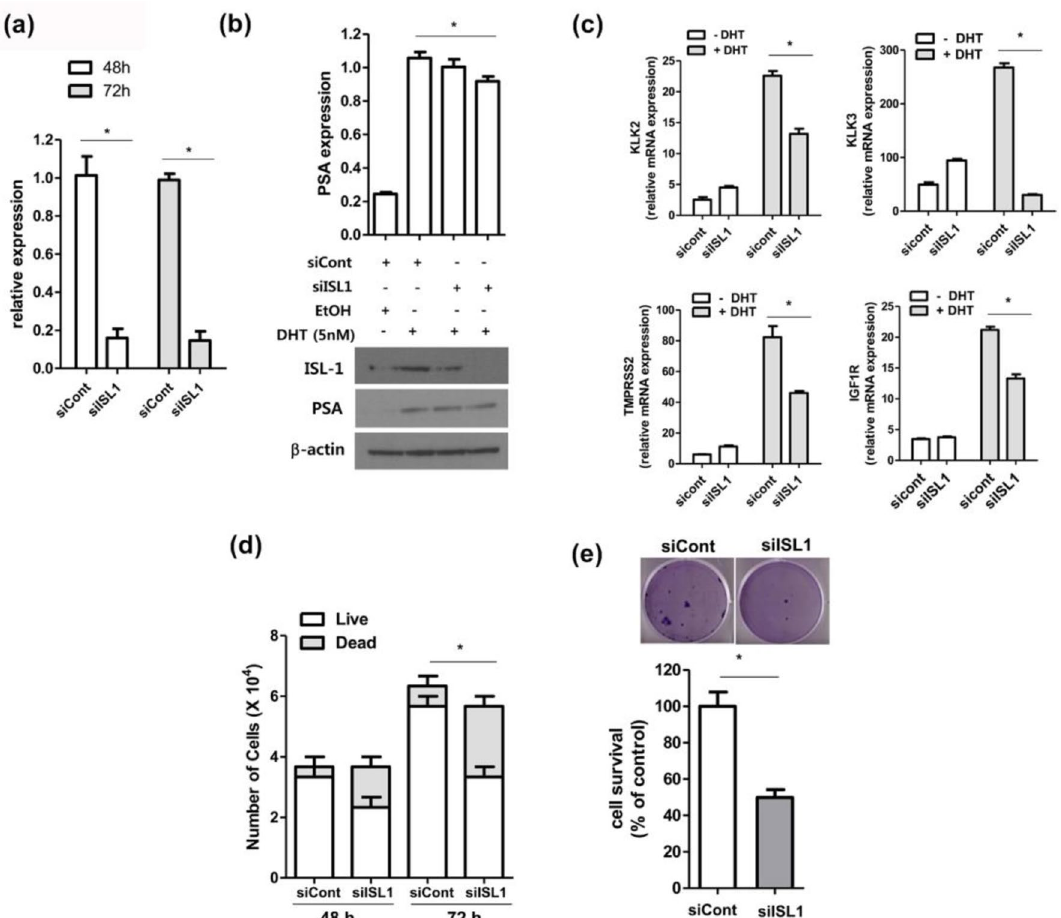
Figure 5. ISL1 is required for AR activity and AR-dependent cell proliferation. ( a ) The efficiency of ISL1 knock- down was measured by comparing mRNA levels of ISL1 in siRNA expressing LNCaP cell lines. ISL1 mRNA levels were measured by qRT-PCR. Error bars represent the mean ± SD of three independent experiments and * denotes p < 0.05 vs. the control siRNA (siCont) group. ( b ) Whole cell extracts were analyzed with anti-ISL1, anti- PSA and anti-β-actin antibodies. For the induction of AR activity, 5 nM DHT (dihydrotestosterone) was added after one day of serum deprivation. Bottom, a Western blotting experiment; top, bands on the Western blot analysis were quantified by densitometry and the data are presented in histogram format. * p < 0.05 (vs. siCont treated DHT). Full-length blots are presented in Supplementary Fig. S6. ( c ) Relative mRNA expression levels of the indicated genes were measured in ISL1 knock-down LNCaP cell lines. Error bars represent mean ± SD of three independent experiments and * denotes p < 0.05 vs. the control siRNA (siCont) group. ( d ) Cell viability in siISL1 transfected LNCaP cells. The cells were plated at a density of 1 × 10 4 cells in 6 well plate for the period indicated. The detached living and dead cells were collected, stained with trypan blue and counted under a microscope using a hemocytometer. Error bars represent the mean ± SD of three independent experiments and * denotes p < 0.05 vs. the control siRNA dead cell (siCont) group. ( e ) Crystal violet staining for colonies from the same number of indicated siRNA expression LNCaP cells. The average relative number of colonies is shown in the lower panel. Error bars represent the mean ± SD of three independent experiments and * denotes p < 0.05 vs. the control siRNA (siCont)